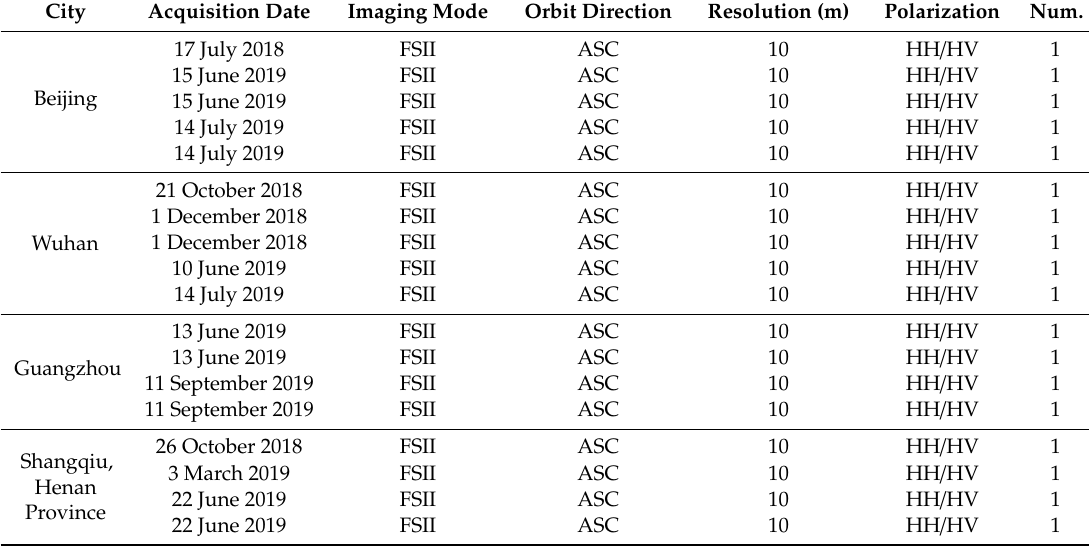
Table 1. Basic information of the GF-3 SAR data.